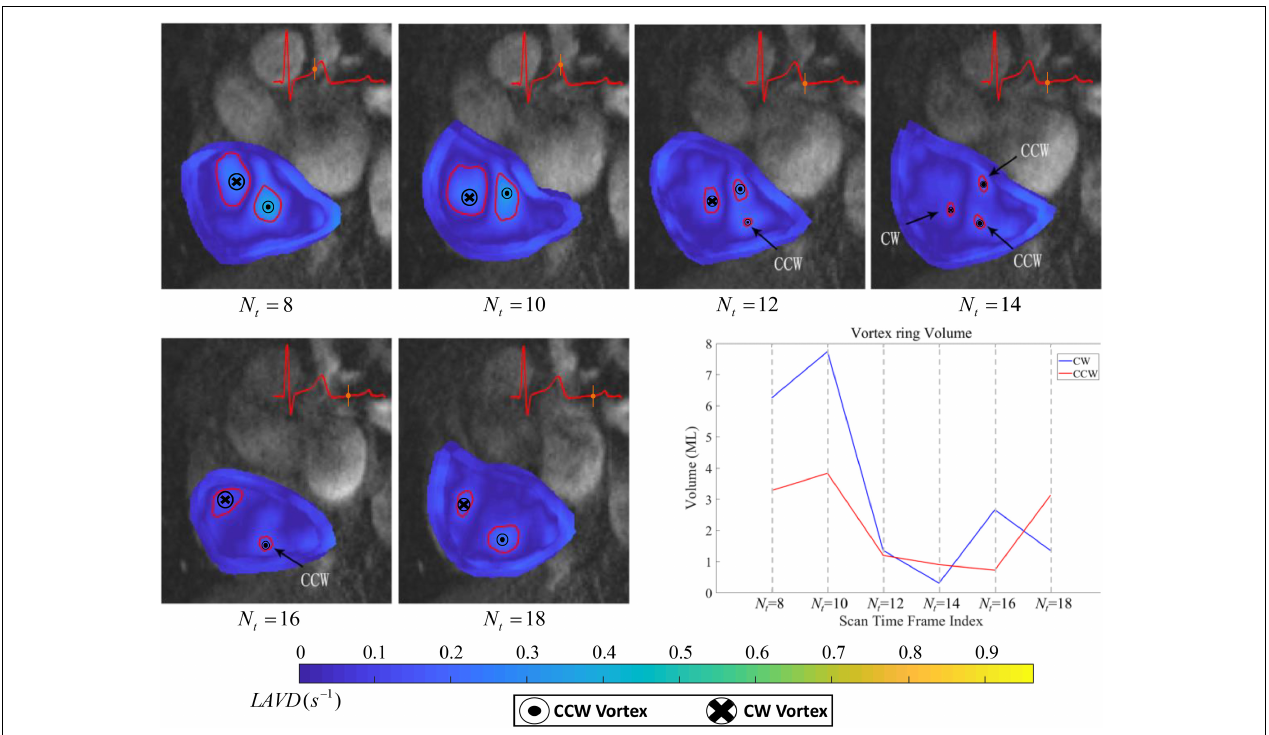
FIGURE 3 | Evolution of Lagrangian vortex rings of a healthy subject. From time frame N t = 8 to 18, the blood is swirling in both the clockwise (CW) and counter-clockwise (CCW) directions simultaneously. The LAVD contour map is produced to indicate its strength. The diagram at the lower right shows the vortex volume measured at the level of the two opposite rotation vortex